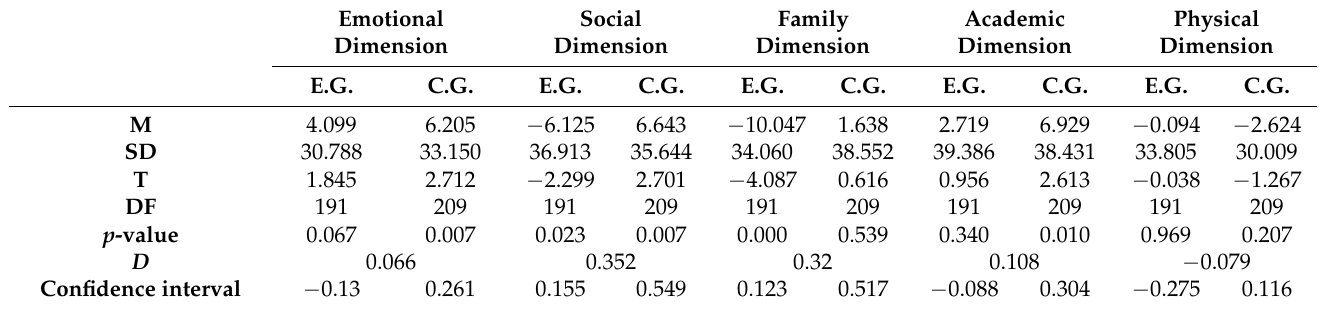
Table 4. Inferential analysis of the self-concept of the experimental group (EG) and the control group (CG)